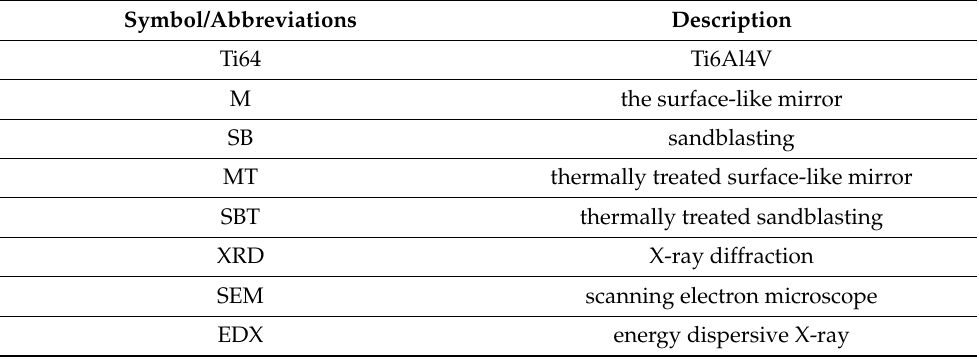
Table 1. Symbols and abbreviations used in the